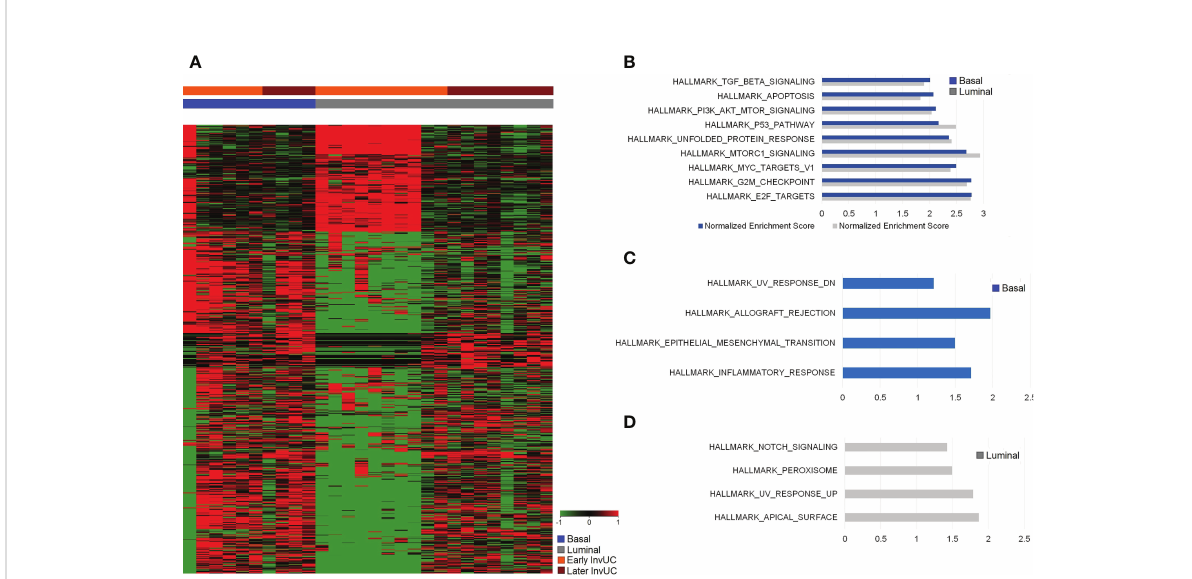
FIGURE 4 RNA-seq and Gene Set Enrichment Analyses (GSEA) of early canine invasive urothelial carcinoma (InvUC) demonstrating shared and subtype- speci fi c pathways of importance in human bladder cancer. In the heatmap (A) , each column represents data from one “ early ” sample, and the samples are grouped according to luminal or basal molecular subtype (see key), with expected heterogeneity observed within and between samples. Differentially expressed genes (n=2785, FC ≥ 2, pcorr ≤ 0.05) were identi fi ed that were unique to early InvUC as compared to normal bladder mucosa from dogs with no urinary disease. Enriched gene sets (Hallmark collection) in early basal and early luminal InvUC were identi fi ed with GSEA and depicted with Normalized Enrichment Score (NES) (B-D) . In addition to shared gene sets between the molecular subtypes, such as TGF b , TP53, PI3K-AKT-mTOR signaling, and apoptosis pathway (B) , marked differences between the subtypes were readily apparent (A, C, D) . In fl ammatory Response, Allograft Rejection, and Epithelial-Mesenchymal Transition gene sets were enriched in early basal tumors (C) , and Notch signaling, UV-Response Pathway, and Apical Surface gene sets were enriched in early luminal tumors (D) . Additional genes and pathways identi fi ed in Ingenuity Pathway Analyses are summarized in Table